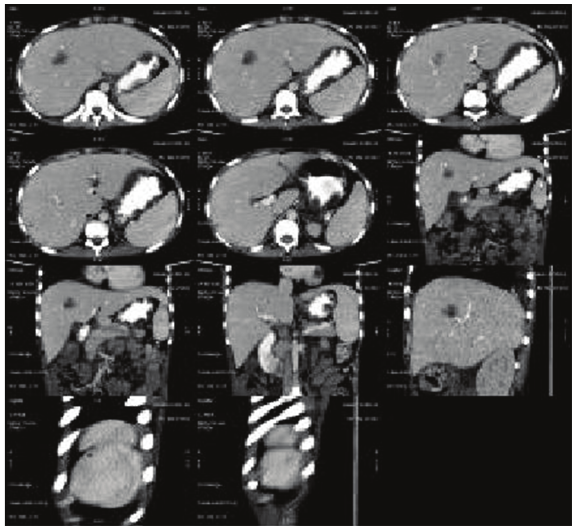
Figure 2: Hepatic and splenic